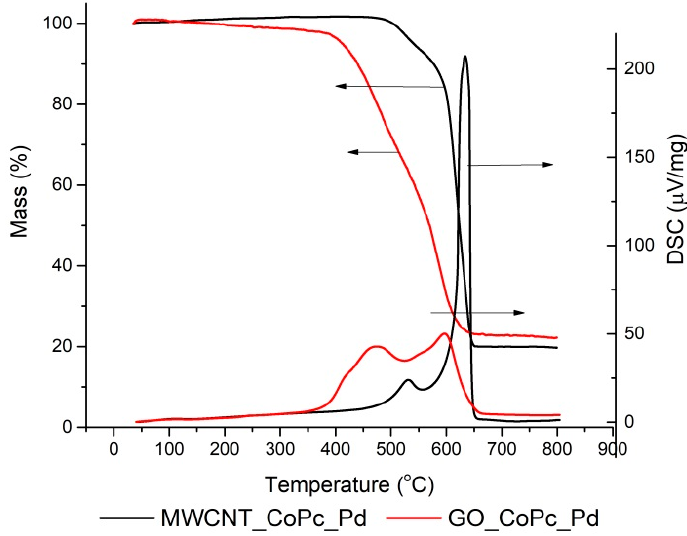
Figure 5. TGA—spectrum for some synthesized samples of catalysts. X-ray fluorescence spectra contain only signals characteristic of copper, cobalt, and palladium metals in all samples under study. The values of the signal intensities ratios of palladium to cobalt and copper, the corresponding catalysts, are practically the same (about 3). This indirectly indicates the same atomic ratio of these metals in different samples of synthesized catalysts. Thermogravimetric analysis indicates a total metal content in the catalysts of about 20%. This is consistent with the calculated amounts in the process of synthesis of these catalysts. For other catalysts, the content was confirmed by the gravimetric method after combustion in